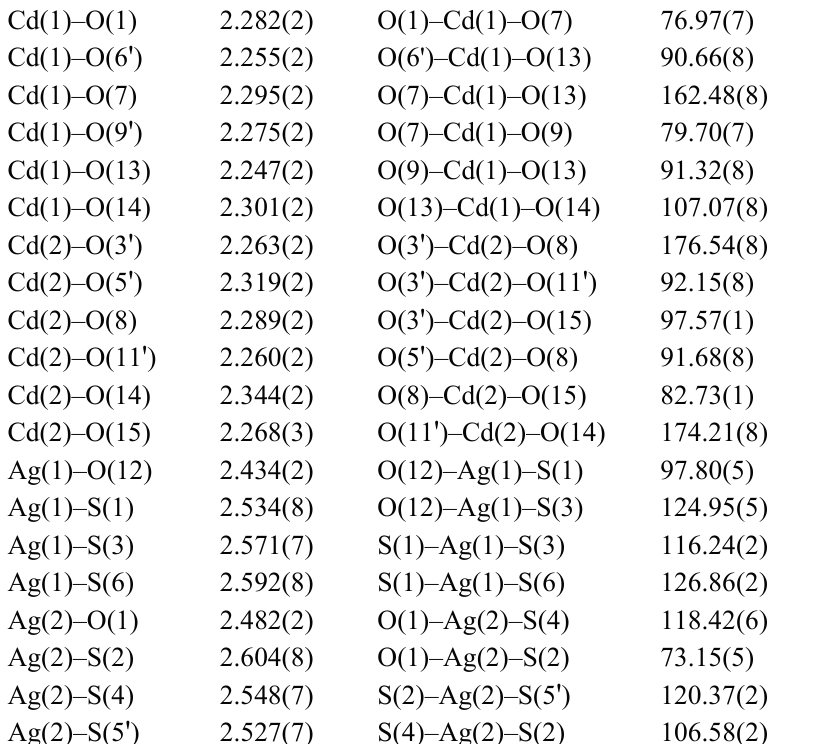
Figure 3. Coordination environments of the silver and cadmium ions and atom labeling in 2 . Hydrogen atoms other than O–H and the noncoordinating water molecules were omitted for clarity. Table 2. Selected bond lengths (Å) and angles (°) in 2